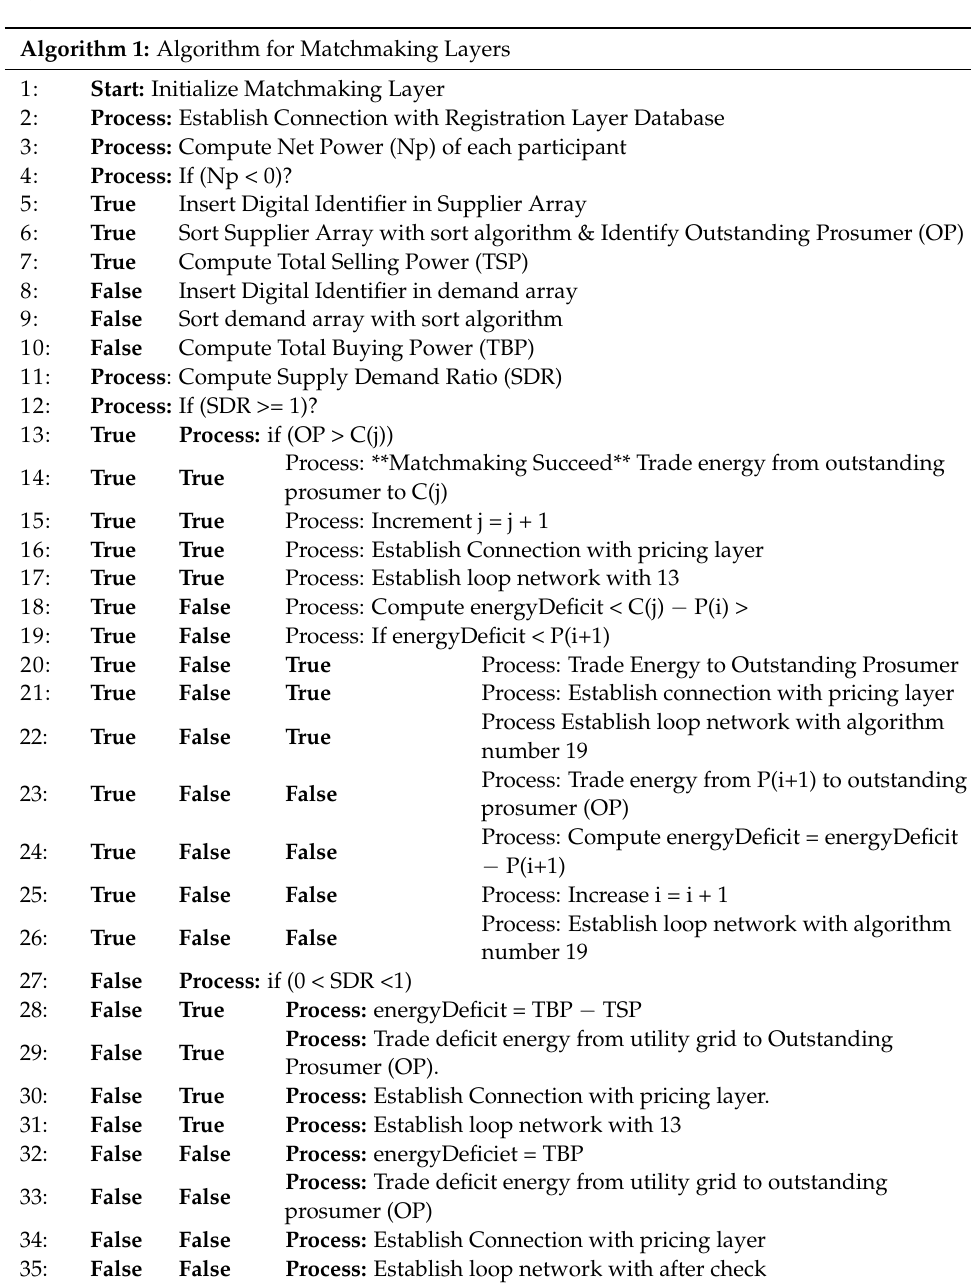
algorithm between the peers. Algorithm 1: Algorithm for Matchmaking